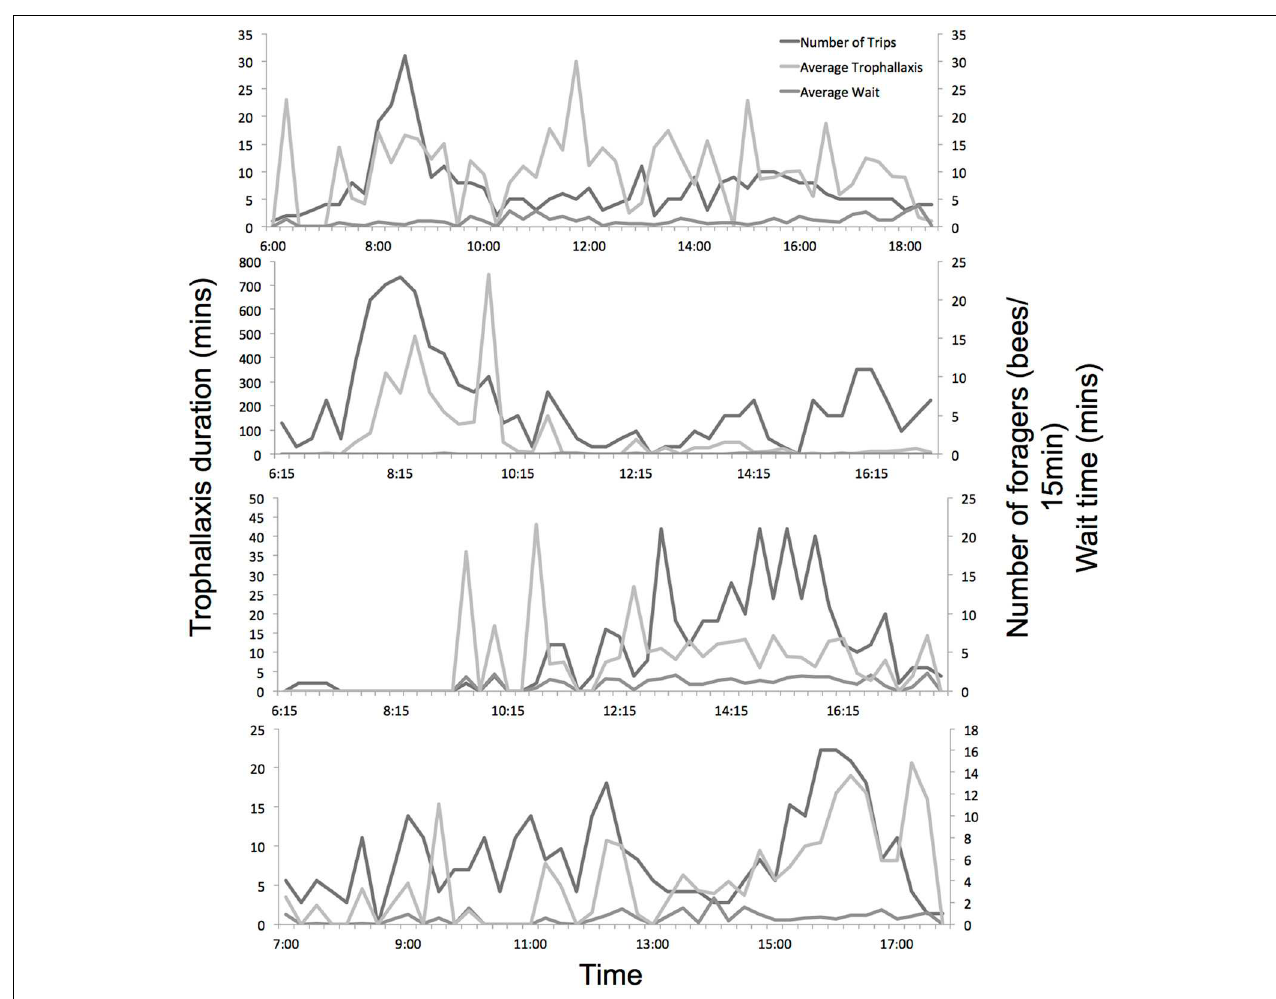
FIGURE 3 | Daily foraging activity, average trophallaxis duration and wait time of all marked foragers across the 4 experiments. Hives were opened and recorded from dawn until